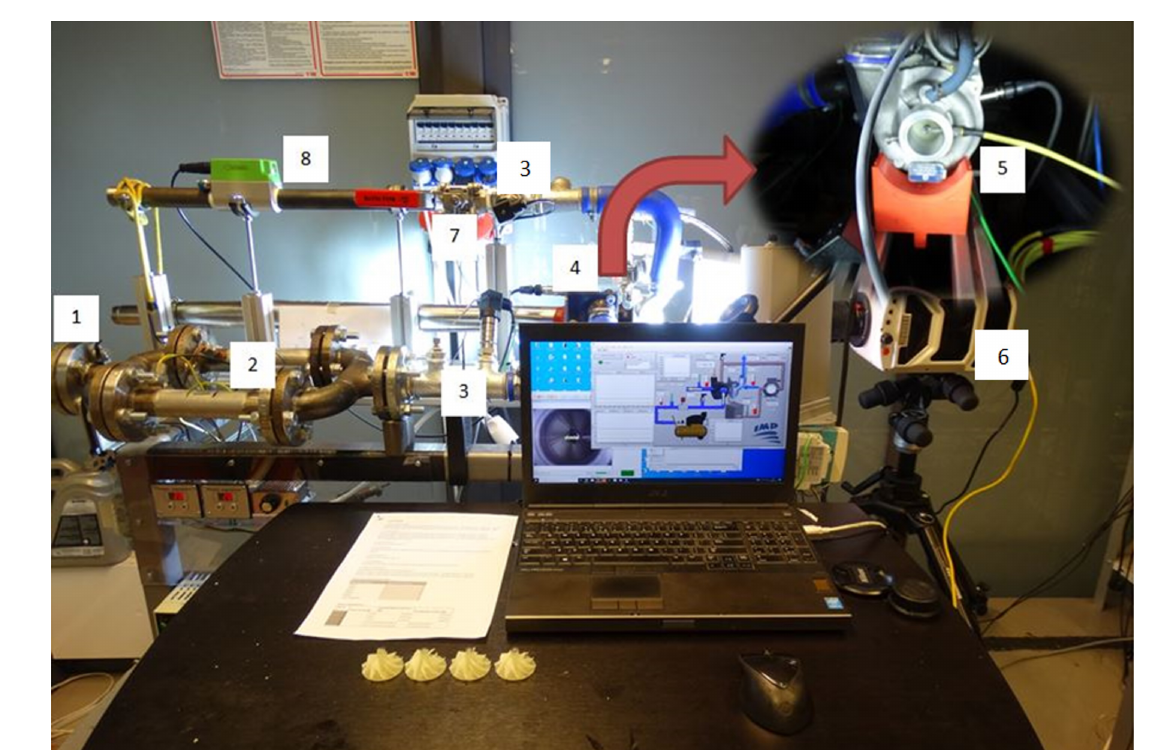
Figure 2. Test stand with a measurement system for registering and determining the flow characteristics of the turbocharger compressor. 1—air supply side with a throttle valve; 2—air pre-heating system; 3— temperature and pressure sensors; 4—turbocharger; 5—speed sensor; 6—high-speed camera; 7—compressor throttle valve;